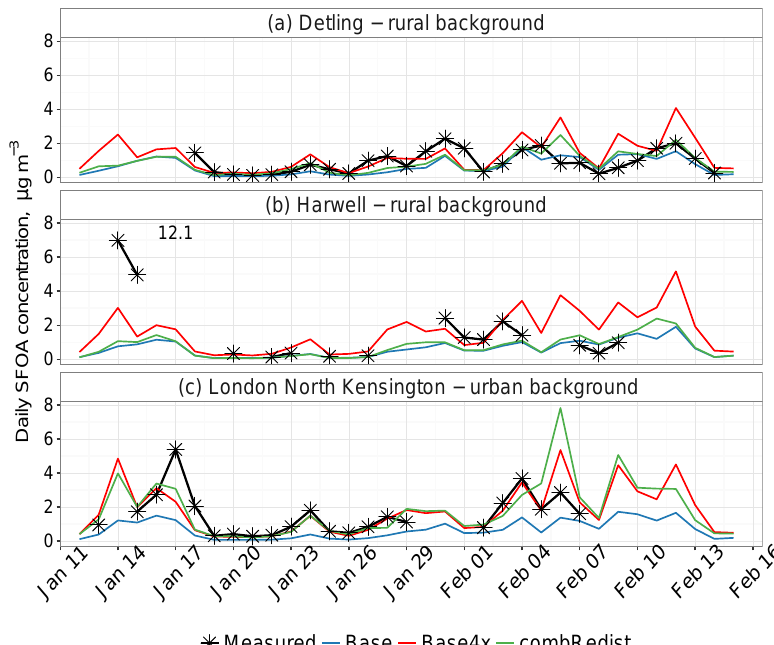
Figure 11. Daily average measured and modelled SFOA concentrations at the (a) Detling, (b) Harwell, and (c) North Kensington measure- ment sites, year 2012. In panel (b) , the concentration measured at 16 January is given as a text label.